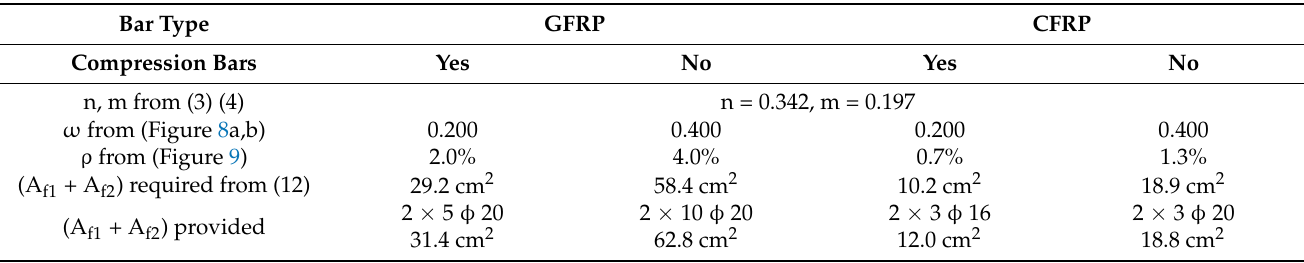
Figure 9. Nomogram for determining the required of reinforcement ratio ρ ( β = 0.10, f co = 30 MPa). Table 3. Calculation